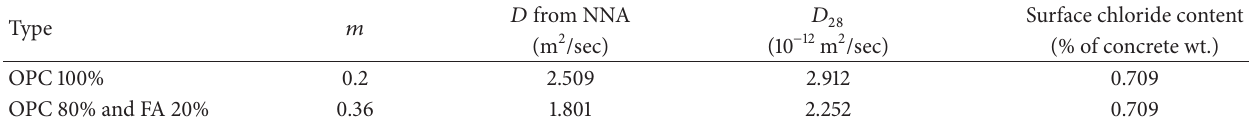
Table 7: Analysis conditions for verification (submerged condition).